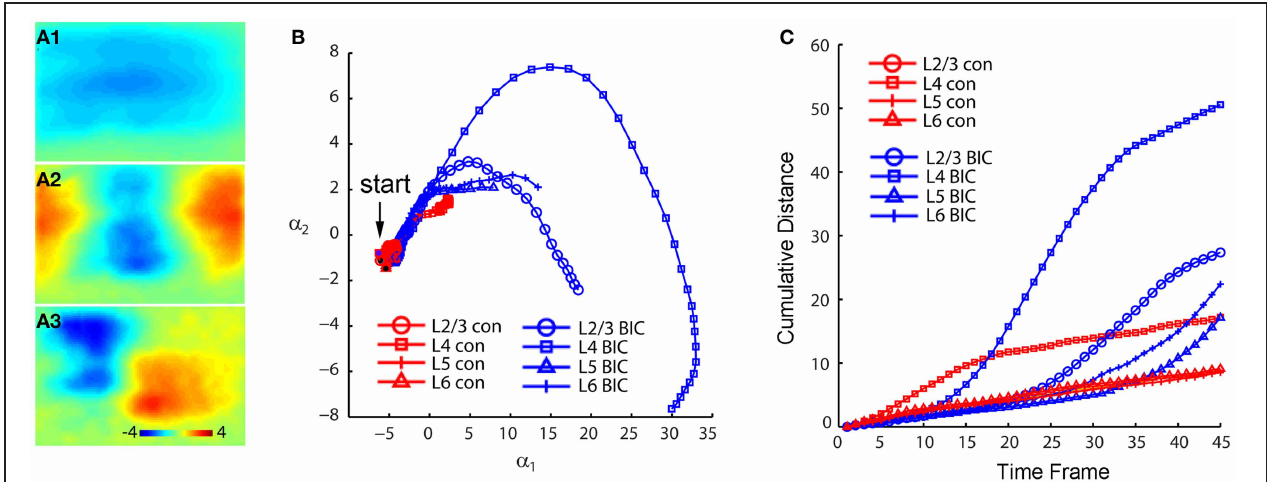
4, 5, and 6) in control and in the presence of bicuculline. The first 45 time frames (99ms) of the image sequence after photostimulation were used for analysis. (B) Shows the 2D projection of the trajectories of VSD responses, shown in the plane α 1 − α 2 . (C) Shows the cumulative propagation distance of the time varying trajectories of VSD responses in the 3D phase space ( α 1 , α 2 , α 3